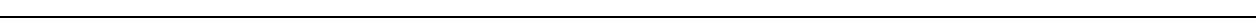
Fig. 5 Altered macrophage markers in rheumatoid arthritis in Mmp12 – / – mice. a Hind ankle widths of Mmp12 + / + and Mmp12 – / – male B10.RIII mice ( n = 18 and 20, respectively, for each time point) after onset of collagen-induced arthritis (day 0), means ± s.e.m. Mann – Whitney t -test: * p < 0.05, ** p < 0.01, *** p < 0.005. b Histopathology of hind ankles after H&E staining (day 18) Mmp12 + / + ( n = 3) and Mmp12 – / – ( n = 3). Bone destruction ( p < 6 × 10 − 5 ), pannus formation (NS not signi fi cant), synovial hyperplasia ( p < 3 × 10 − 5 ), and subsynovial in fl ammation ( p < 7 × 10 − 4 ) were quanti fi ed as a histopathological score ( p < 9 × 10 − 4 , means ± s.d.), two-tailed unpaired Student ’ s t -test: * p < 0.05, ** p < 0.01. c Representative images of H&E, IFN- γ , iNOS, MHCII, and CD36 immunostaining of hind ankle joints of Mmp12 + / + ( n = 3) and Mmp12 – / – ( n = 3) mice. Here and in g : N NETs; C cartilage; S synovial space; arrowheads, high antibody or H&E staining; scale bars, 100 μ m. d Immunostaining quanti fi cation of Mmp12 + / + versus Mmp12 – / – male B10.RIII mice hind ankle joints for IFN- γ ( p < 2 × 10 − 5 ), iNOS ( p < 1 × 10 − 3 ), MHCII ( p < 2 × 10 − 5 ), and CD36 ( p < 2 × 10 − 2 ) (means ± s.d.), two-tailed unpaired Student ’ s t